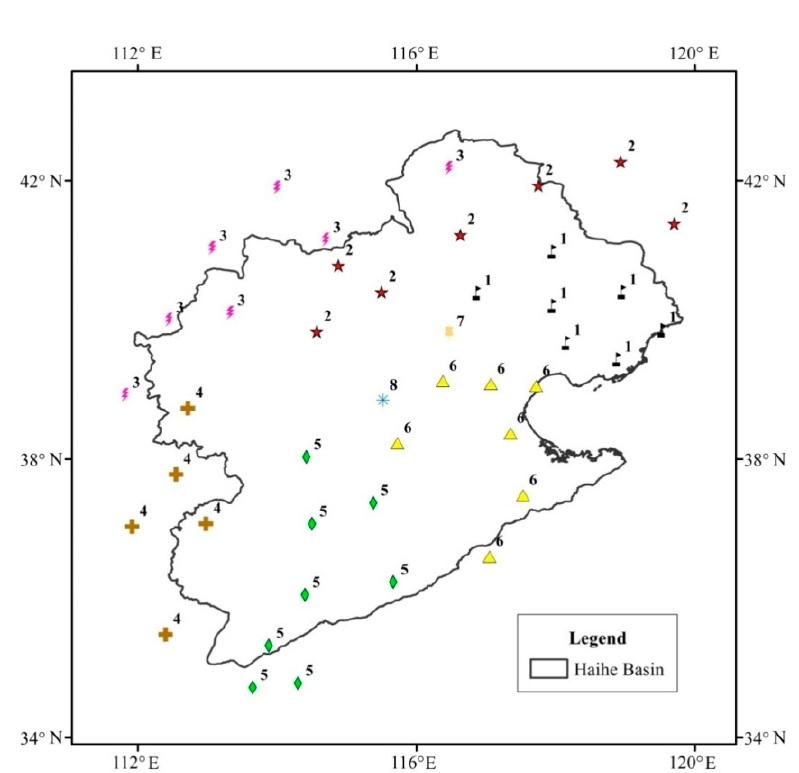
Figure 2. The Canopy and k -means clustering results and spatial distribution of the stations in the HRB.